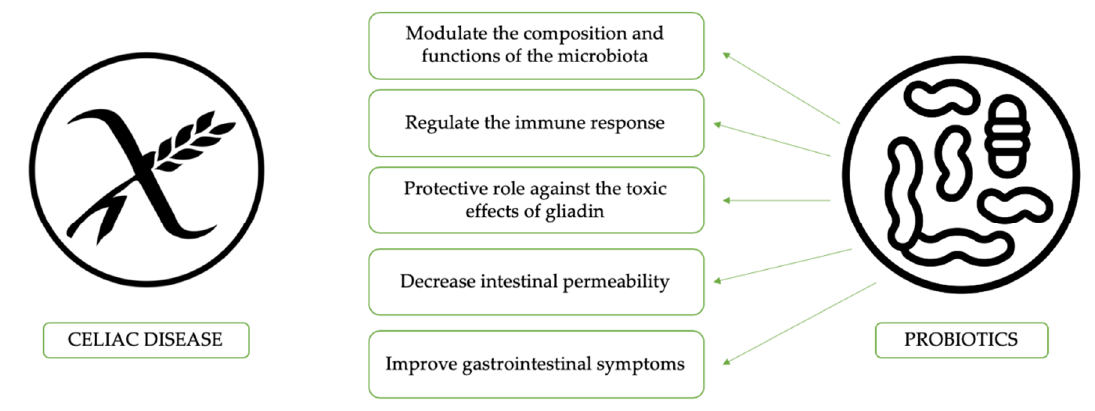
Figure 1. The potential benefits of probiotics use in celiac disease patients.